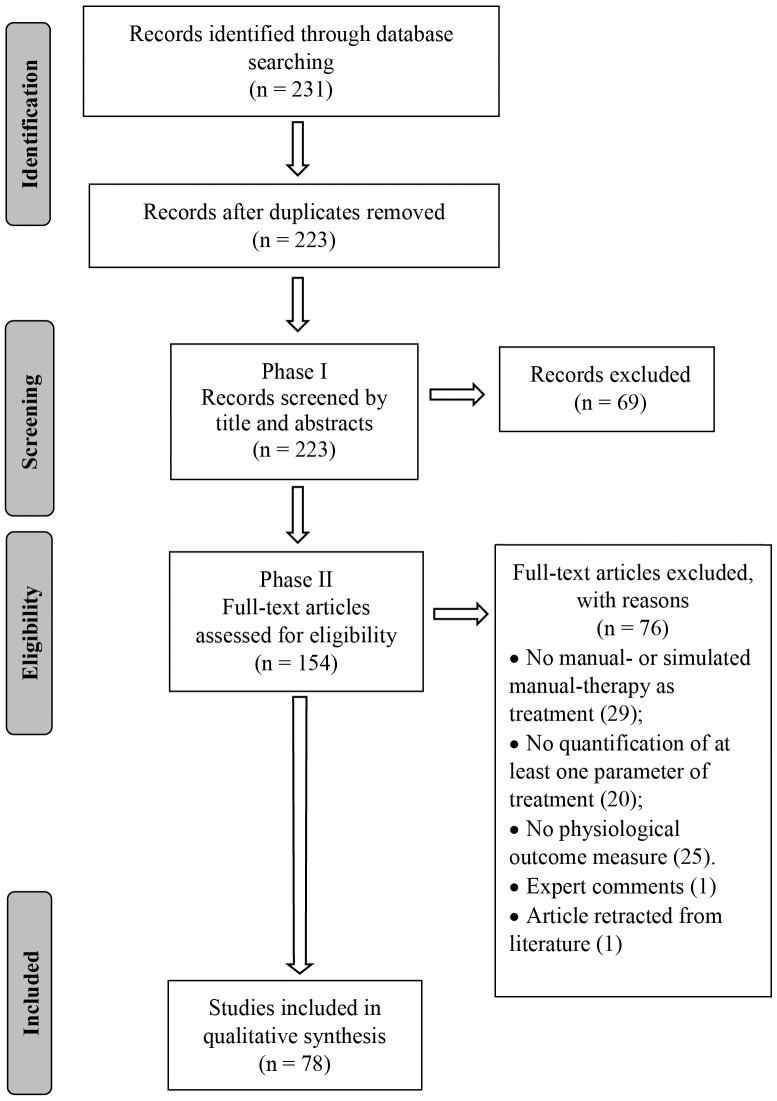
Flowchart diagram.